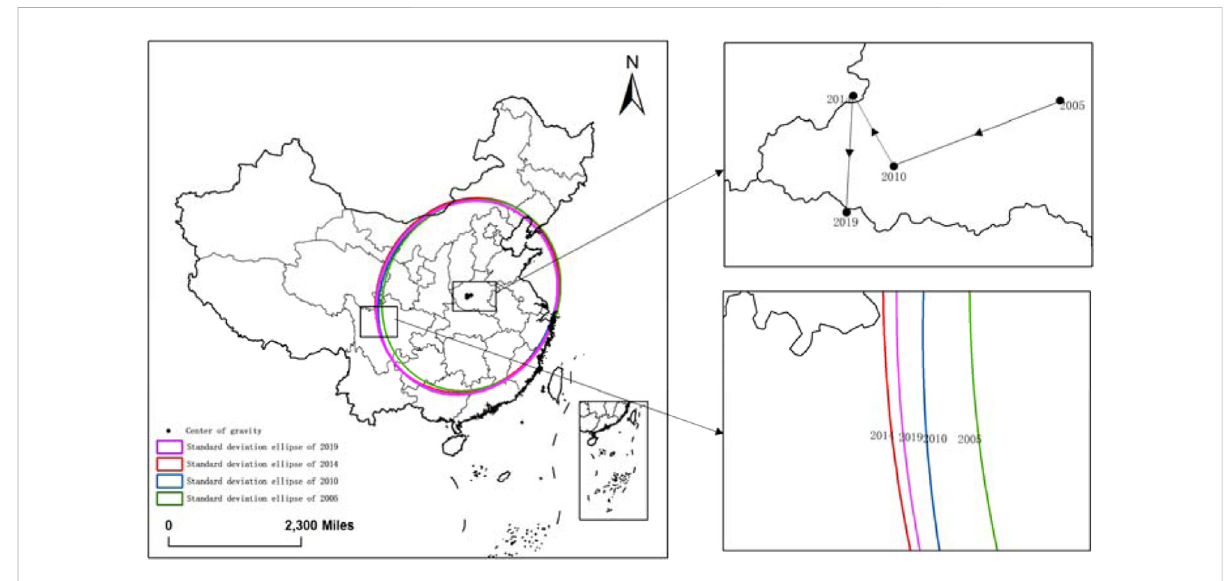
FIGURE 6 Spatial distribution of evolutionary trend of the coupling coordination